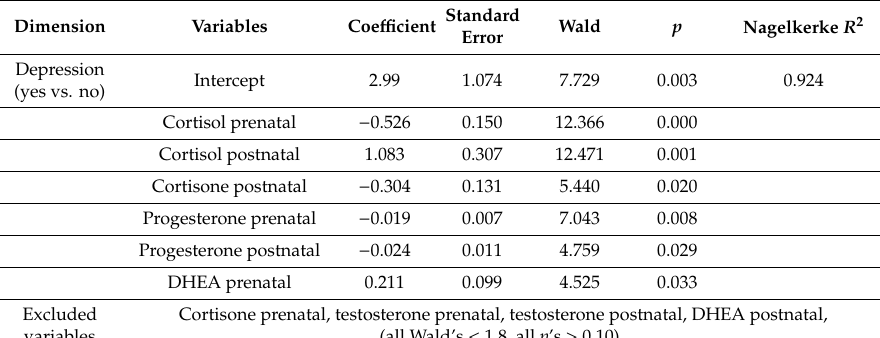
Table 5. Binary logistic regression with post-partum depression (yes vs. no) as dependent variable, and antenatal hair steroid levels (cortisol; cortisone; testosterone; progesterone; DHEA) as predictors.